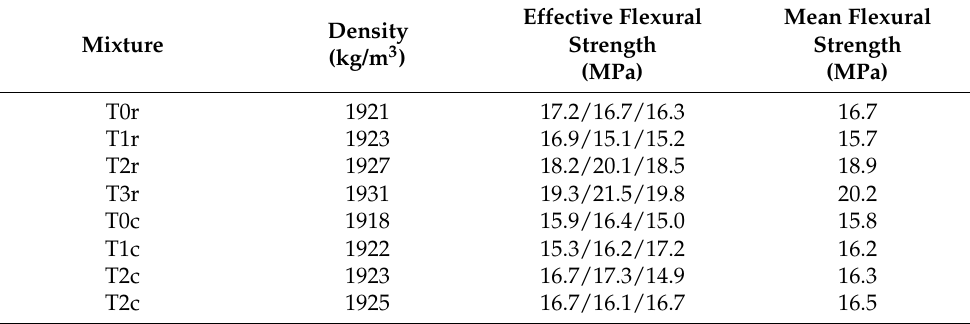
Figure 3. Schematics of the preliminary test set up: ( a ) EN 196-1 three-point bending (dimensions in mm); ( b ) specimen under flexural failure. Table 3. Modulus of rupture for the tested specimens and